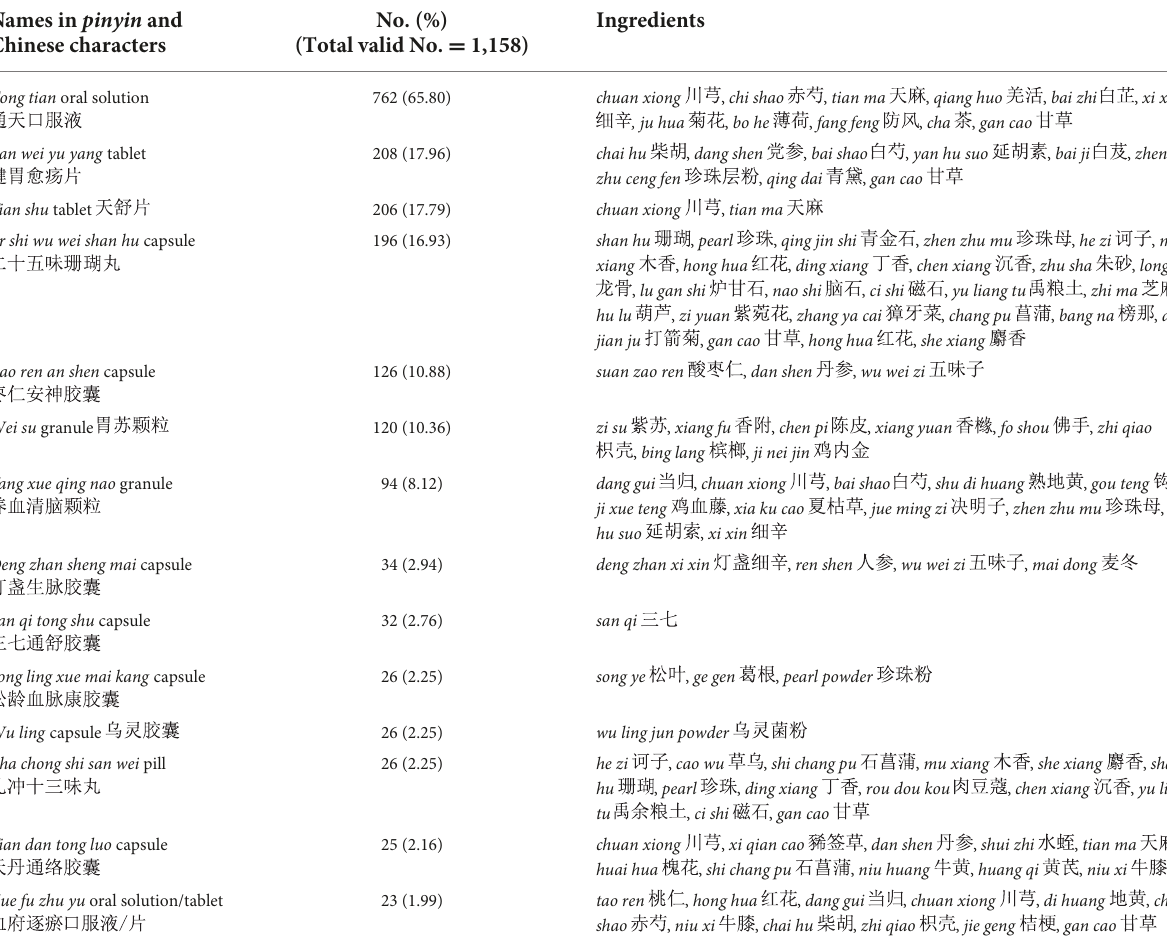
TABLE 8 Frequently used patented Chinese herbal medicine products for which patients reported improvements. Names in pinyin and No. (%) Chinese characters (Total valid No. =